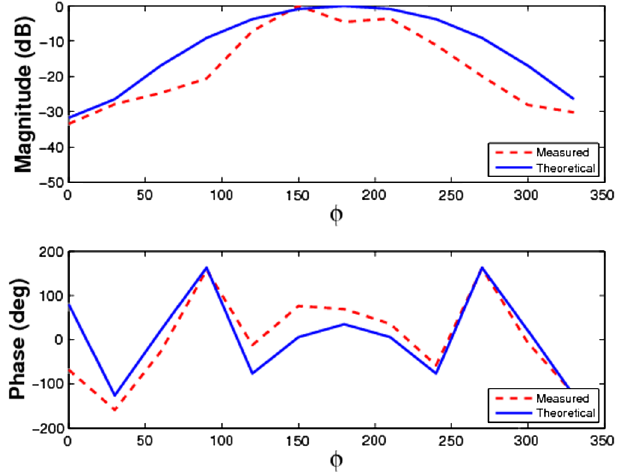
FIG. 14. The theoretical total tangential magnetic field H ’ at the boundary of a PEC cylinder (blue line) compared to the measured values found using the loop antennas in the waveguide measurement (red dashed